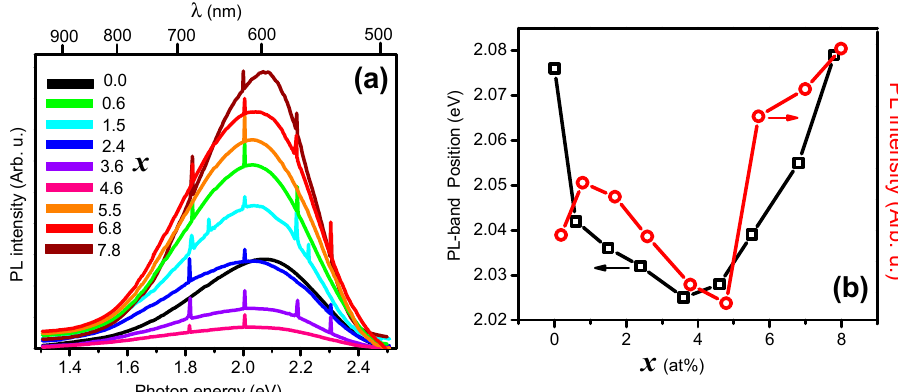
Figure 6. ( a ) Photoluminescence spectra of all the set of Cd 1-x Er x Se samples. ( b ) Energy position of the PL band maximum (left axis) and PL band intensity (right axis) versus x .